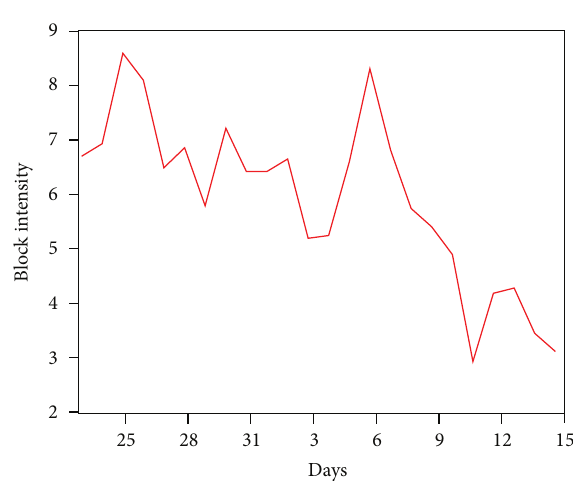
Figure 3: Block intensity (dimensionless) as a function of time: January 21–February 15, 2014.